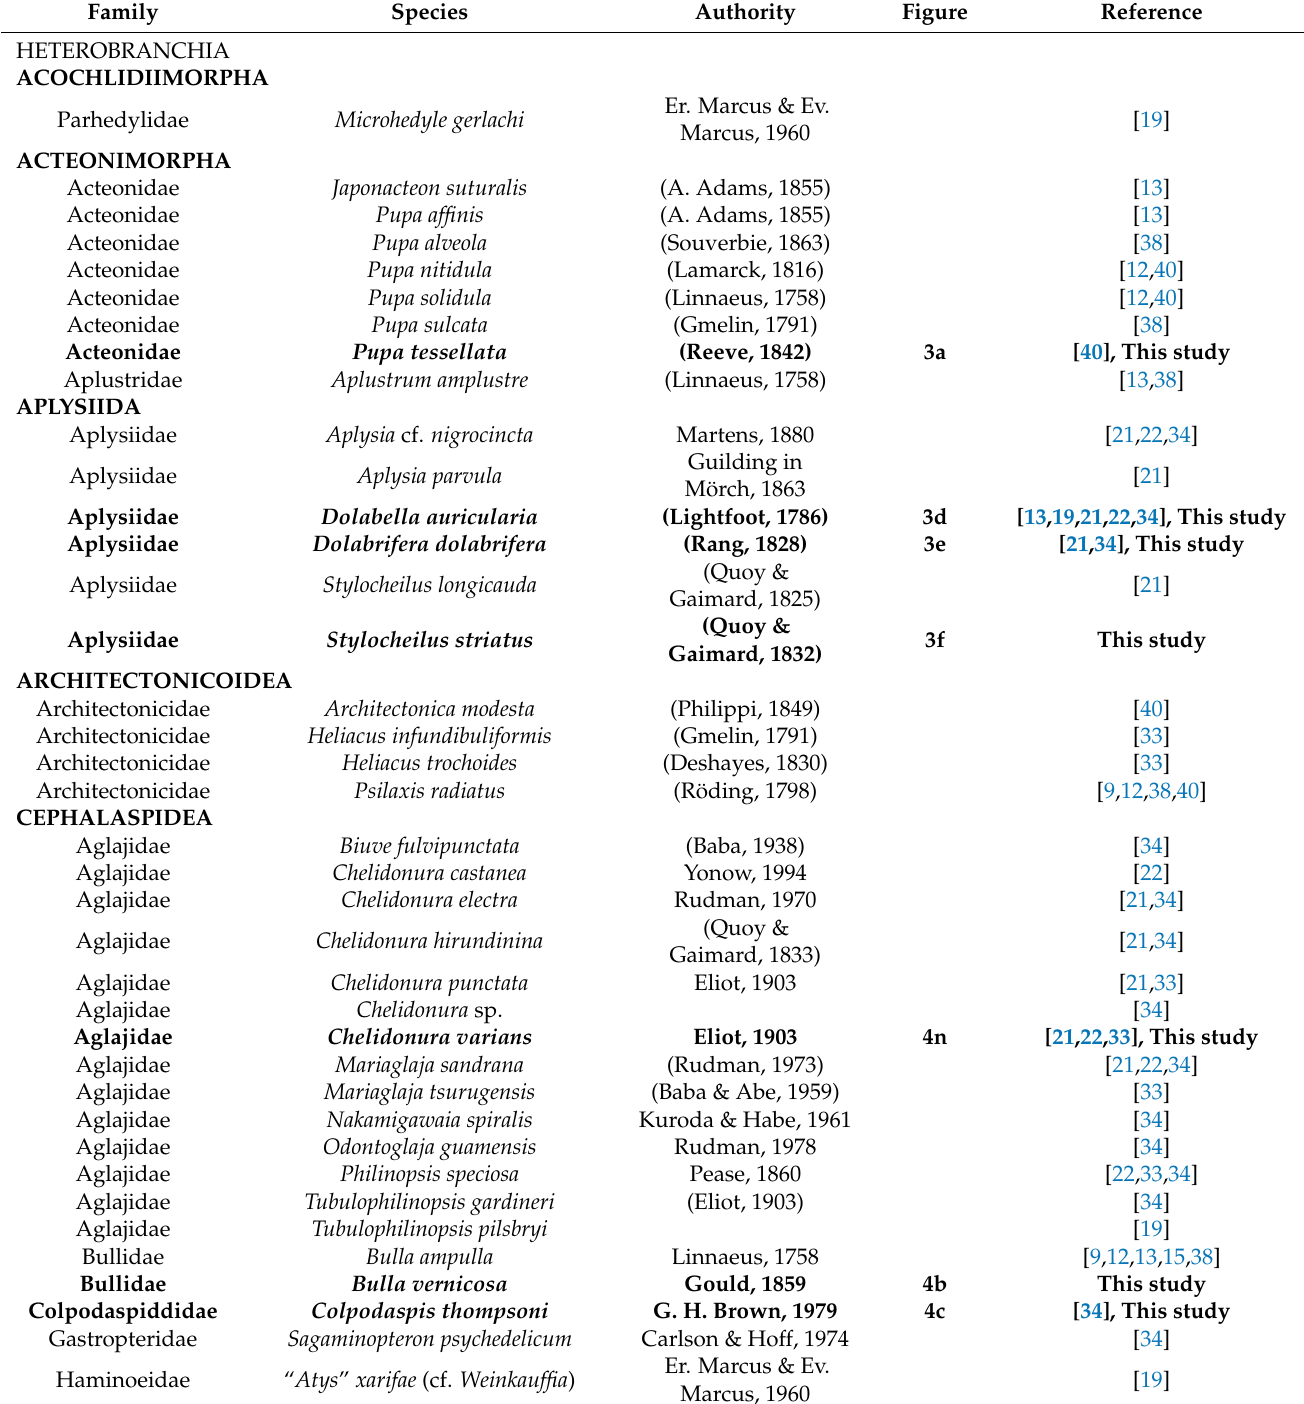
Table 1. Checklist of heterobranch and vetigastropod species found in the Maldives, including new species and undetermined species ( sensu Gosliner et al. [23] for heterobranchs). Species collected in this study are highlighted in bold, figure citations are included. Species names recorded from the literature were updated according to WoRMS [18] unless explicitly discussed in the source reference. From the OBIS database [33], only records with ‘preserved specimens’ were